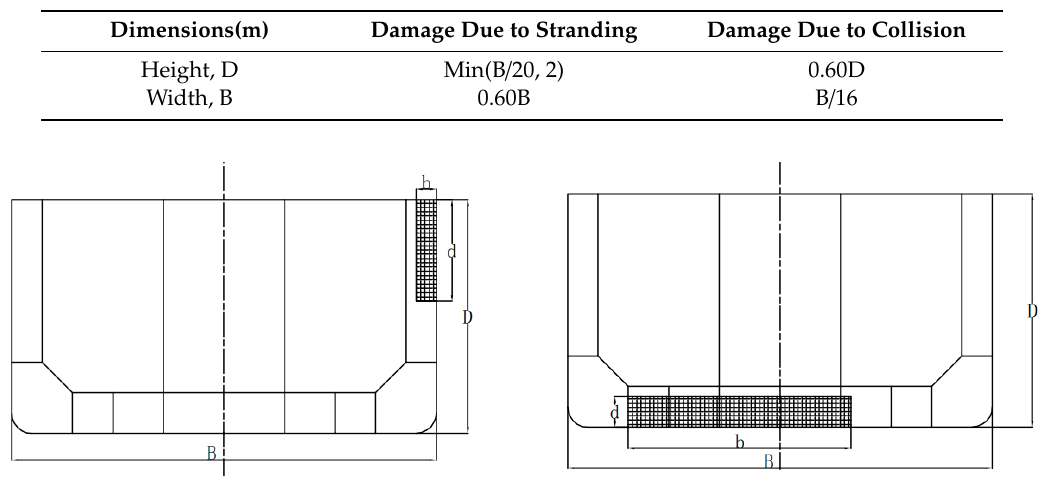
Figure 7. Location of damage in each case (data were from [10].